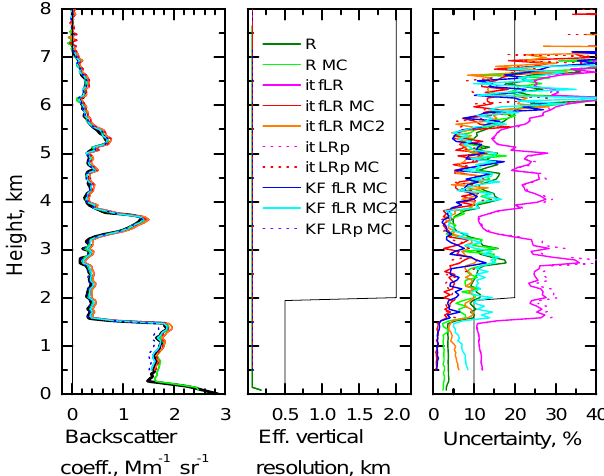
Figure 1. Profiles of the particle backscatter coefficient at 532nm (left panel), its effective vertical resolution (center panel), and rela- tive statistical uncertainties (right panel). The colored lines show the results of ELDA corresponding to the different tested meth- ods which identified in the legend by short IDs (See Table 2 for full descriptions of the tested methods). The bold black line (below the colored lines) in the left panel shows the input data of the al- gorithm inter-comparison exercise. The Raman backscatter profile was obtained with automated smoothing. All other profiles were calculated with the vertical resolution of the pre-processed signals of 60m. Thin black lines indicate the general constraints of all re- trievals. Maximum allowable smoothing was 500m and 2km below and above 2km altitude, respectively (center). Maximum allowable relative errors were 10 and 20% below and above 2km, respectively